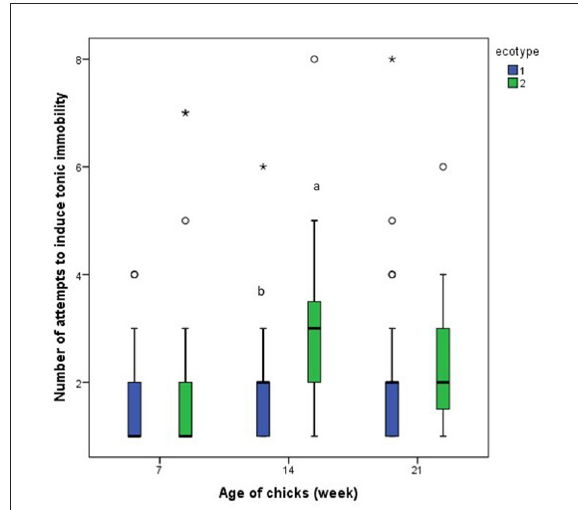
FIGURE9 Number of attempts to induce tonic immobility in two ecotypes (1 = Yoruba and 2 = Fulani) of Nigerian indigenous chicks at days 7, 14, and 21 post-hatch. ab Means differ at P < 0.05 at day 14 post-hatch. Outliers in the data are depicted by the symbol “* or ◦ ”.